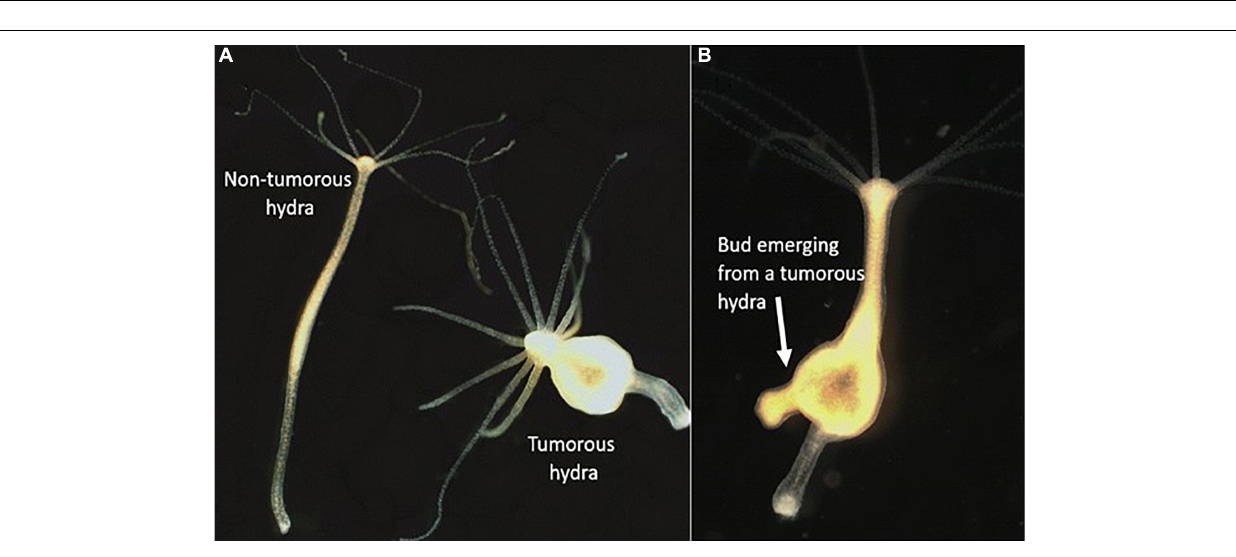
FIGURE 6 | Tumors in Hydra oligactis. (A) Non-tumorous and tumorous hydra. Neoplasia not only severely alter the polyp’s body shape, but tumor-bearing individuals also show a shift in their microbiota and display a higher number of tentacles (Domazet-Lošo et al., 2014; Rathje et al., 2020). (B) Vertical transmission of tumoral cells in Hydra oligactis. After emergence, buds from tumorous hydra are morphologically similar to non-tumorous hydra, but after 4–6 weeks, they develop tumors as their parental polyp (Photo Justine